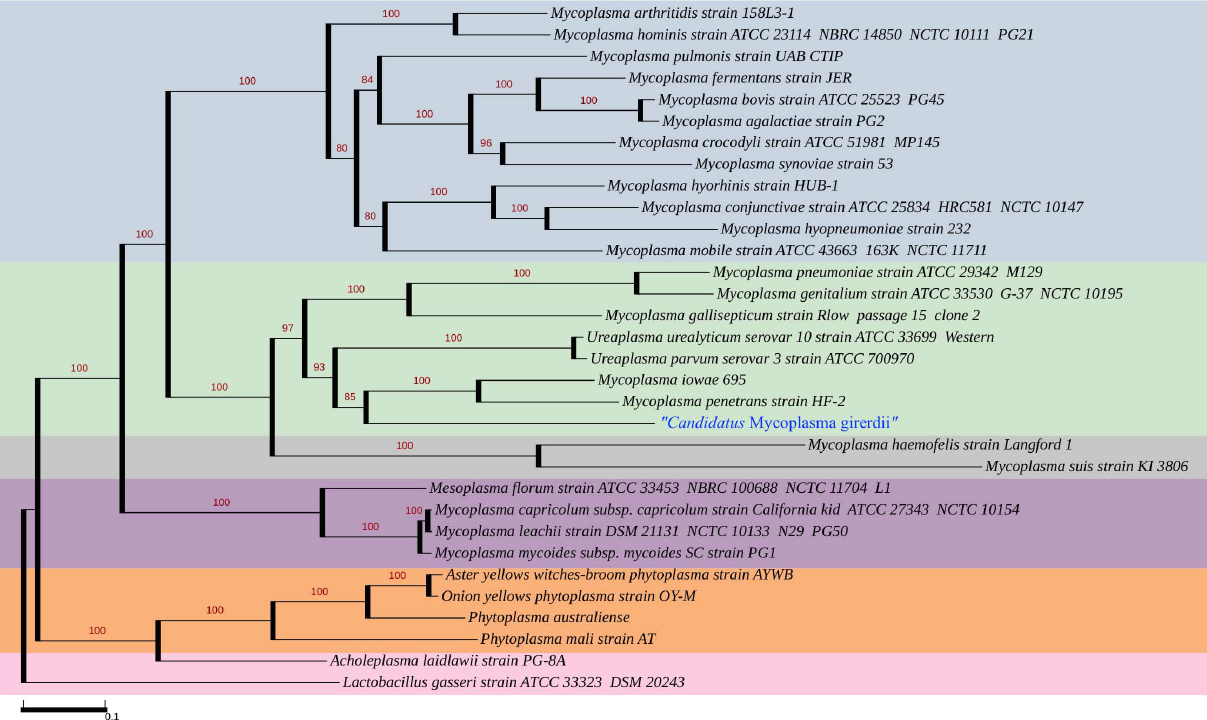
Figure 5. Phylogenetic Tree based on inferred amino acid sequences confirms placement of ‘‘ Ca. M. girerdii’’ in the Pneumoniae group. ‘‘ Ca . M. girerdii’’ is located within the Pneumoniae group, denoted in green, in a subclade along with the Ureaplasma species, M. iowae and M. penetrans . The tree was inferred using amino acid sequences of 57 orthologs (Tables S4, S5, and S6). Numbers at nodes correspond to the support values from 1,000 bootstrap replicates.